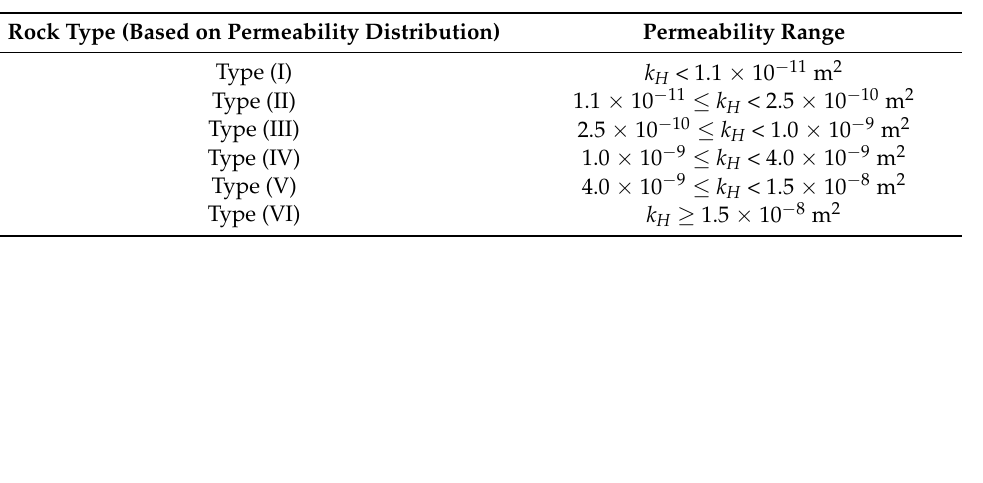
Table 1. Rock types defined in the model and their corresponding horizontal permeability— k H (m 2 )